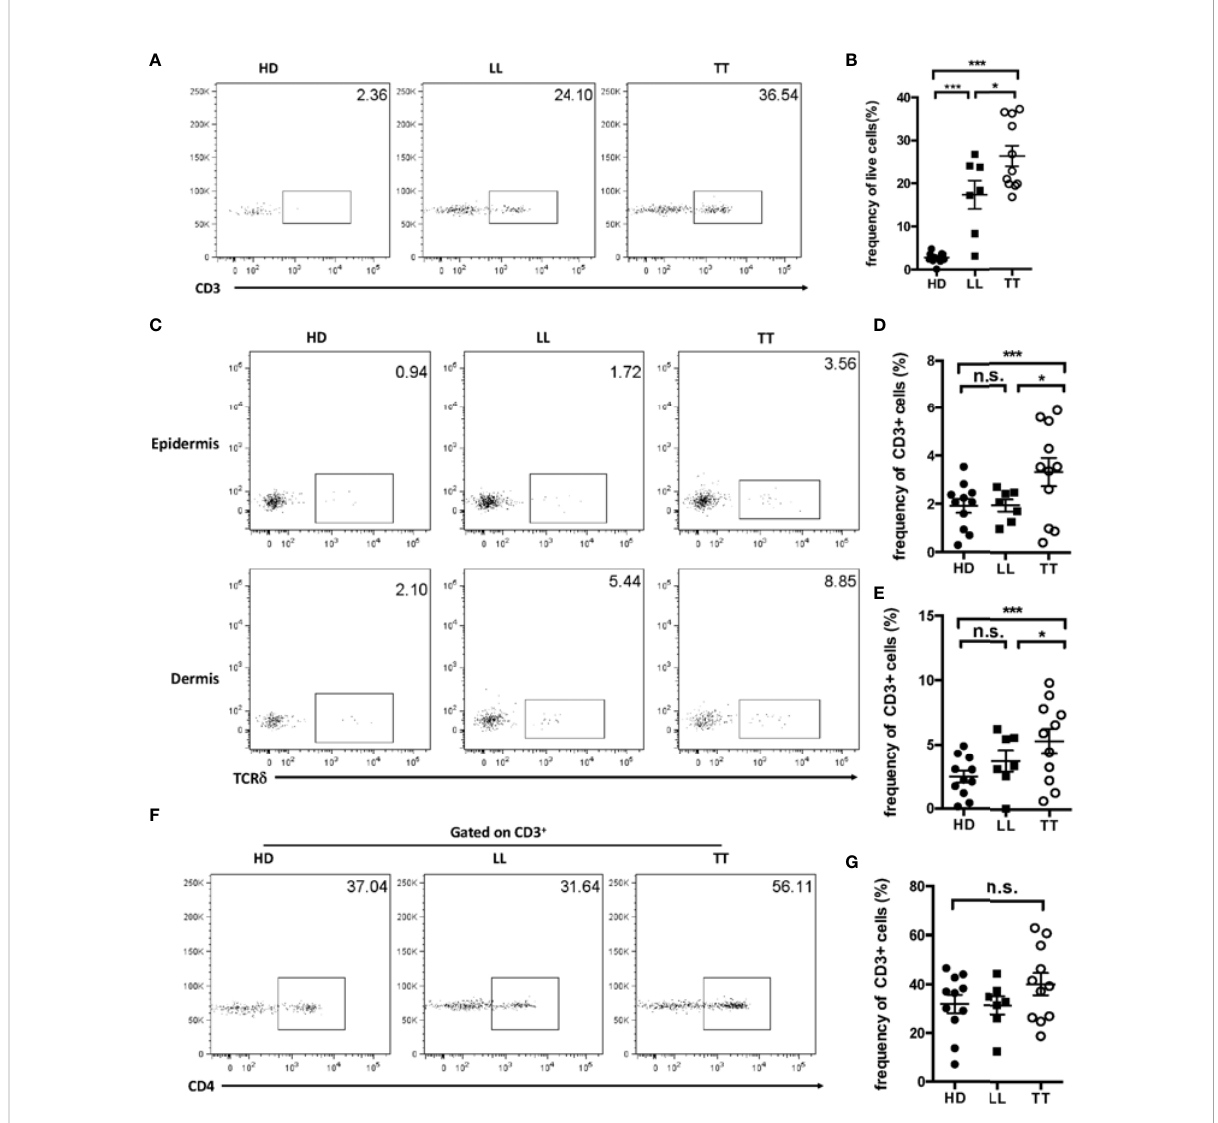
FIGURE 1 Enrichment of gd T cells in leprosy lesions. (A) Dermal cells from healthy controls and skin lesion of leprosy patients were analyzed for CD3 by fl ow cytometry. (B) Statistical results in (A) . (C) Epidermal and dermal cells from healthy controls and skin lesion of leprosy patients were analyzed for gd T cells by fl ow cytometry. (D) Statistical results in (C) . (E) Dermal cells from healthy controls and skin lesion of leprosy patients were analyzed for CD4 by fl ow cytometry. (F) Cells from healthy controls and leprosy patients were analyzed for CD4+ T cells by fl ow cytometry. (G) Statistical results in (F) . Flow plots gated on live cells were representative from 11 TT patients, seven LL patients, and 11 healthy donors. Percentage was shown as mean ± SEM. Statistical analysis was performed by a one-way ANOVA or t test. n.s.: no signi fi cance; * p < 0.05; *** p <